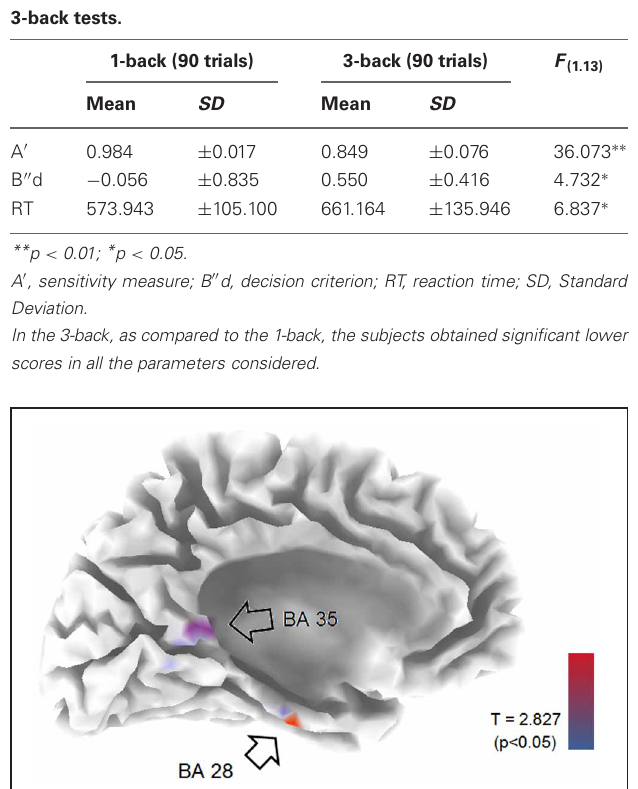
FIGURE 1 | LORETA representation of the mesial surface of the left hemisphere of the brain. Arrows and colored spots indicate areas were statistically significant differences between 1-back and 3-back tasks were detected. BA, Brodmann areas. Graphic representation of the levels of significance, and threshold values ( T ), are reported in the lower right